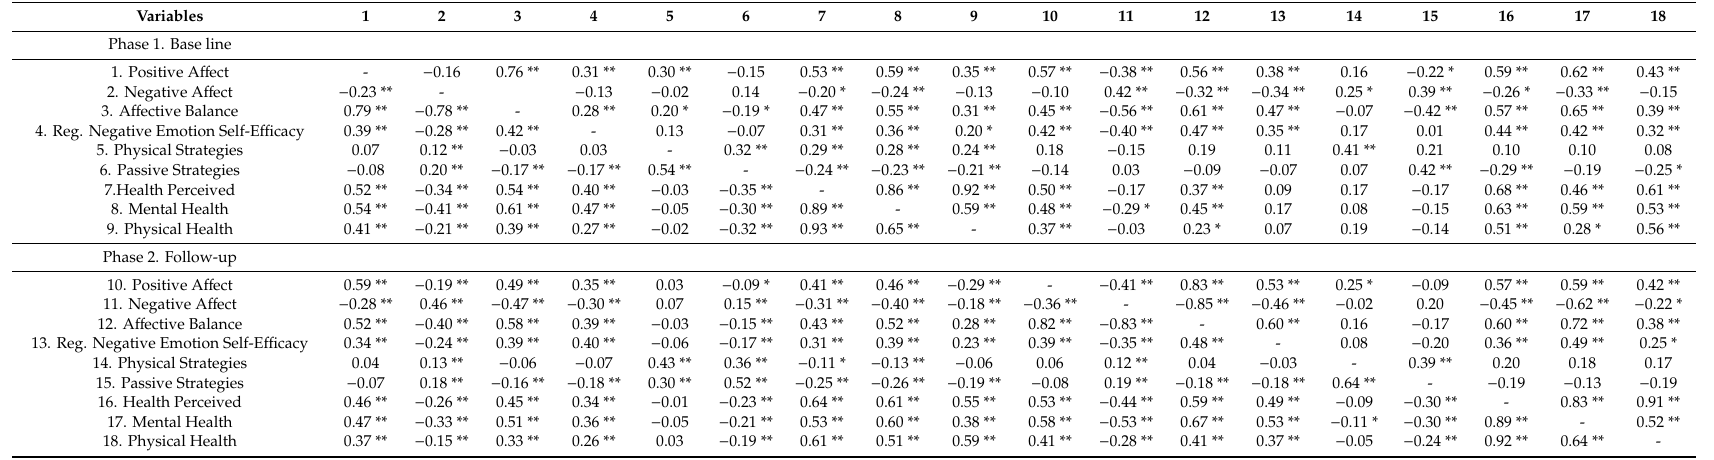
Table 2. Bivariate correlations for all psychological and regulatory strategies variables studied at baseline and follow-up phases. Correlations for men are on the lower diagonal, and correlations for women are on the upper